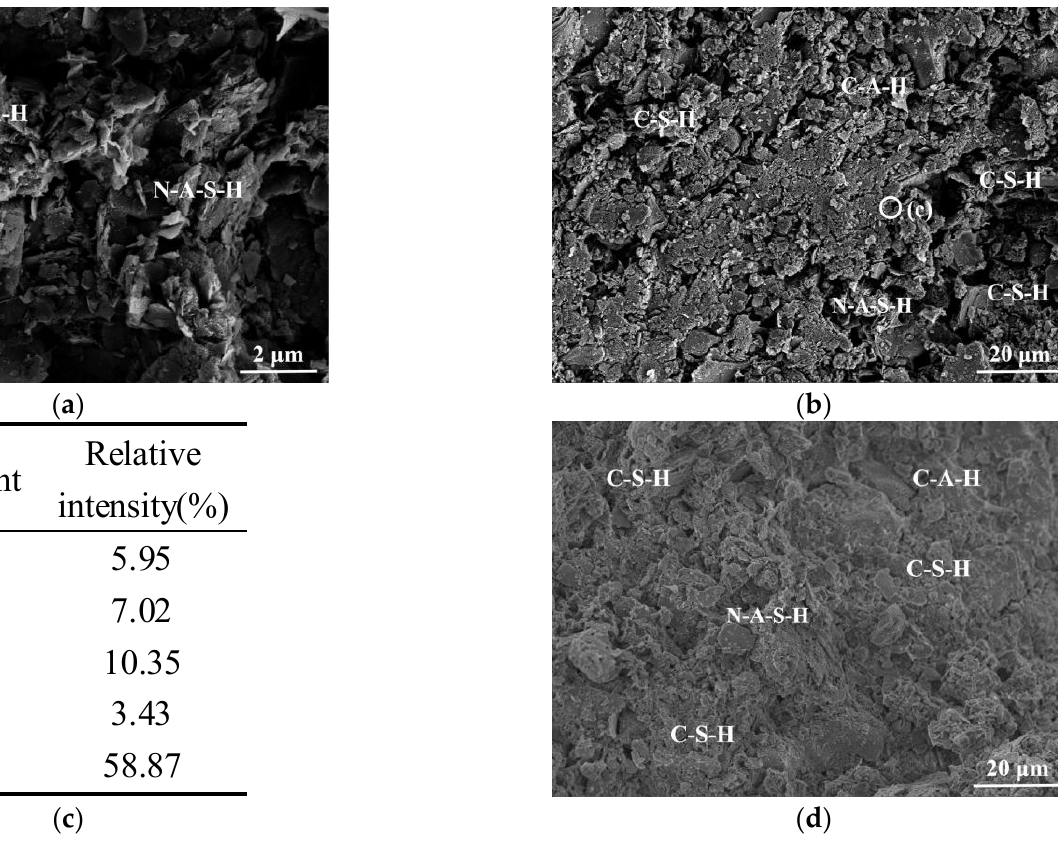
Figure 7. SEM images of II-3: ( a ) and ( b ) 7 d; ( c ) EDS result—7 d; ( d ) 28 d. As shown in Figure 8, compared with C-2, a large number of three-dimensional network products and voids are observed in the SEM image of II-5. Combined with subsequent EDS analysis, the gelatinous products can be qualitatively analyzed. The EDS result in Figure 8c shows that the geopolymer gel (point c1) is a coexistence composed of N-A-S-H and C-S-H. The main components of the gelatinous product at point c2 are Na, Al, and Si elements, which confirms that the network product is the N-A-S-H gel under a low-calcium system. The increase in the amount of N-A-S-H gel produced is positively correlated with the increase in fly ash content in II-5 [52]. It can be observed from Figure 8a,b that this stable three-dimensional network structure hinders the secondary reaction between the N-A-S-H gel and the hydration product of the slag, which results in a decrease in the mutual adhesion between soil particles [52]. In Figure 8d, there is a small amount of unreacted fly ash around the gelatinous products, and partially exposed soil particles are observed. The above UCS test results show that the UCS of II-5 are 0.79 and 1.15 MPa at 7 d and 28 d, respectively, which is even lower than C-2. This indicates that excessive fly ash will have a detrimental effect on the UCS of stabilized soil